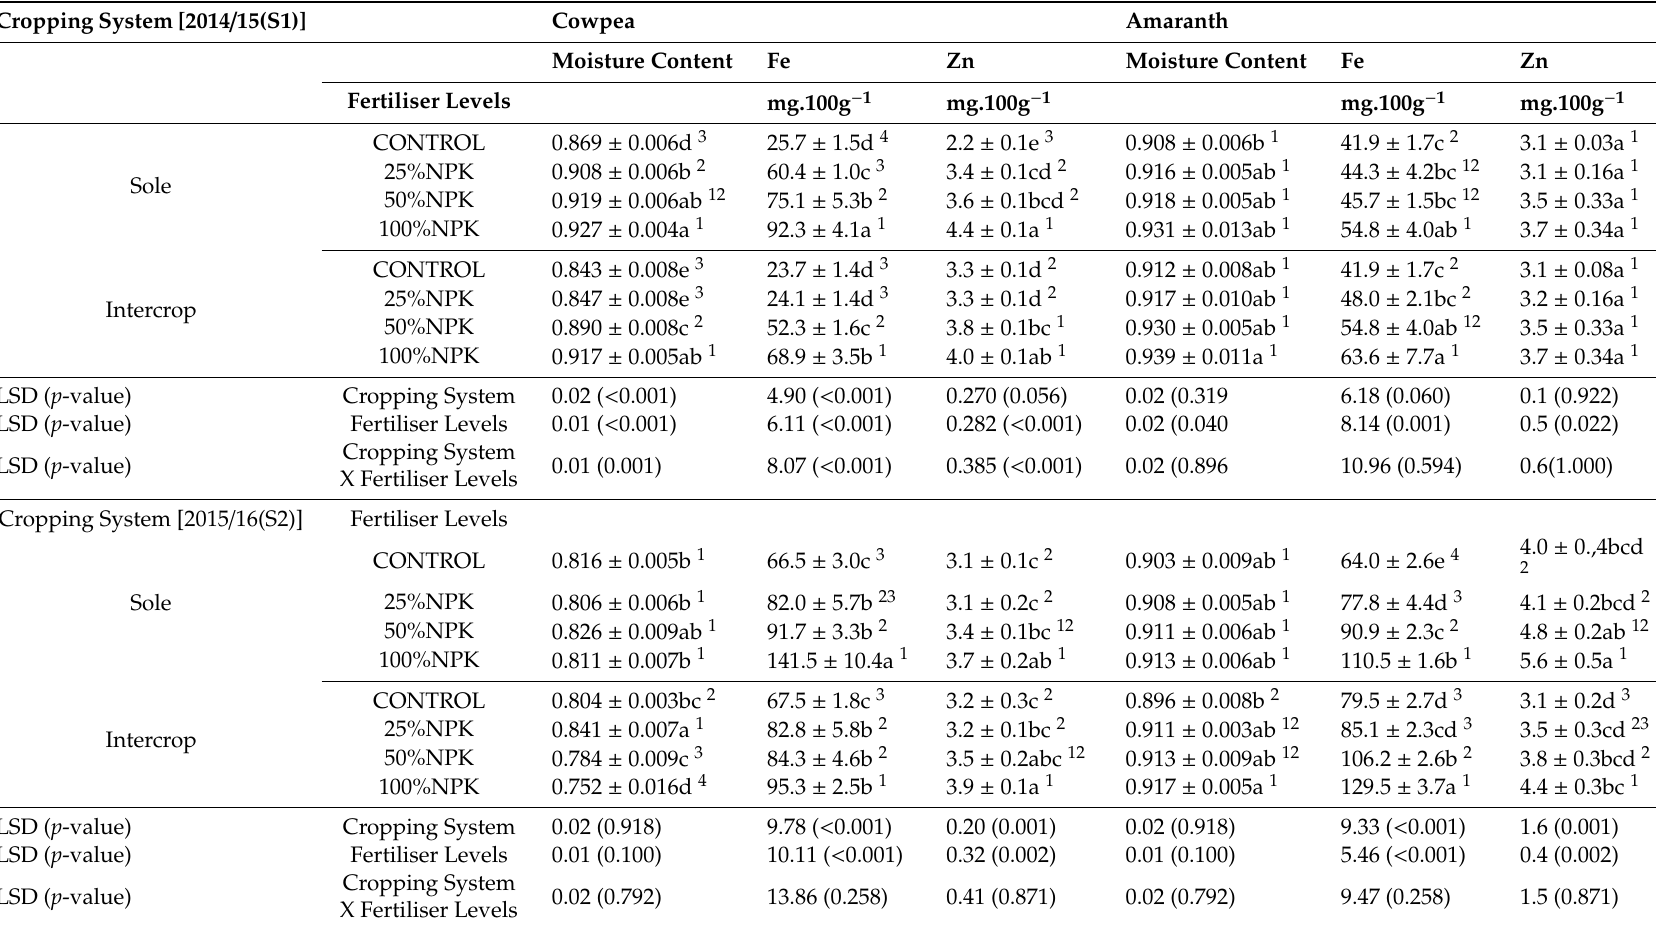
Table 4. Moisture content, iron mass concentration (Fe) and zinc mass concentration (Zn) of cowpea and amaranth under sole and inter-cropping systems at four fertiliser (NPK) levels in 2014 / 15 and 2015 / 16 summer